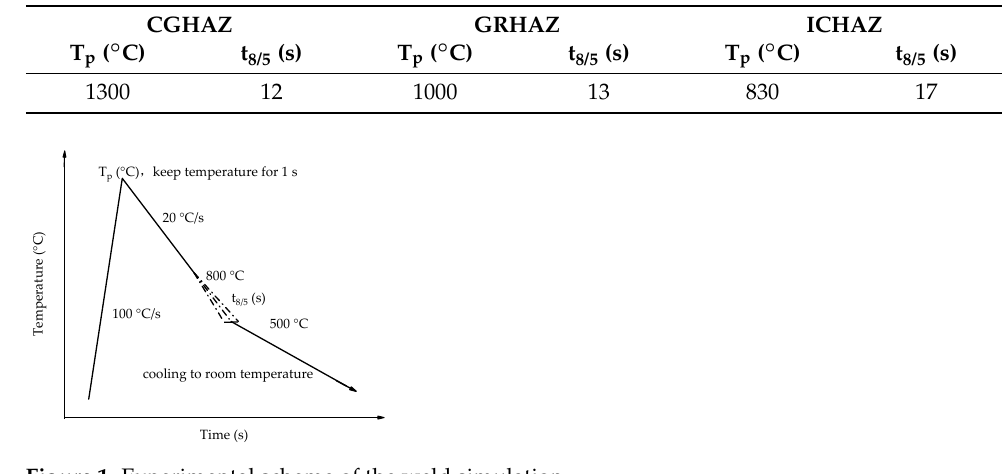
Figure 1. Experimental scheme of the weld simulation.